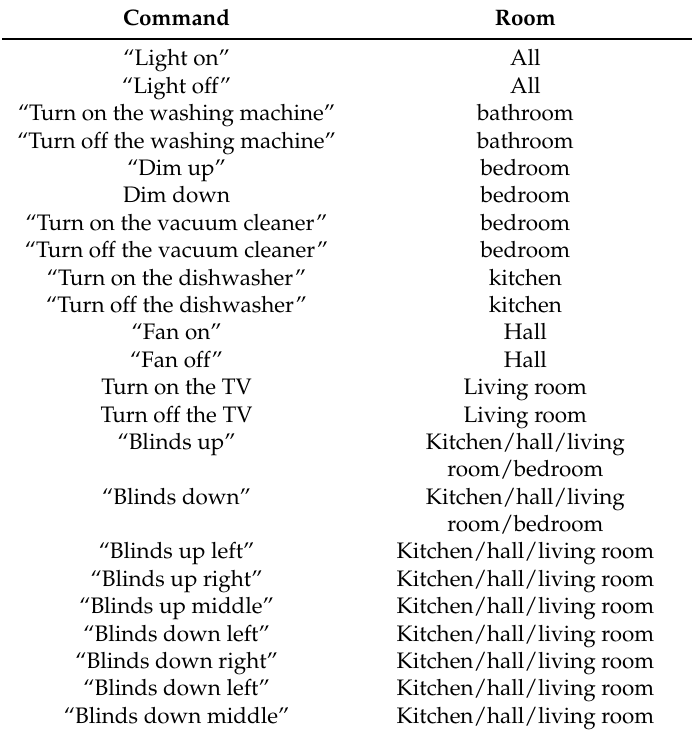
Table 3. Glossary of commands for voice control of “smart”